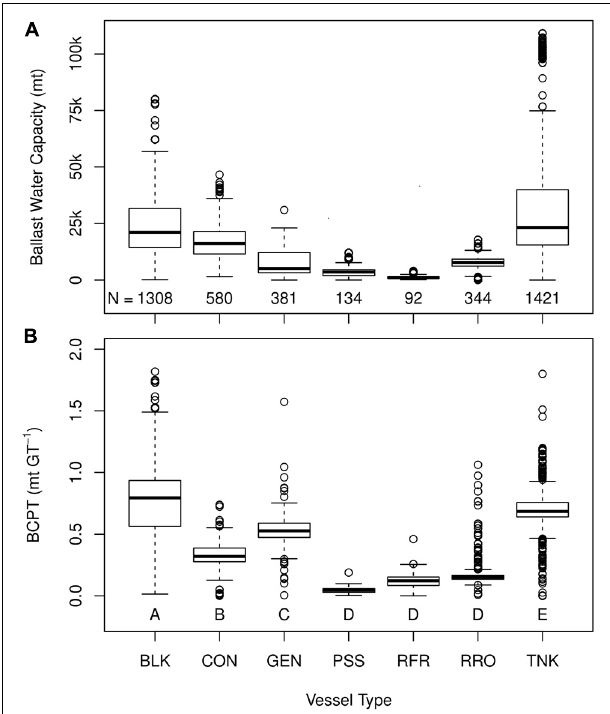
FIGURE 2 | Boxplots showing ballast water capacity (A) and proportion of ballast water capacity to overall vessel size (B) for seven common vessel types. Numbers across the bottom of panel (A) represents the numbers of vessels for each vessel type. Different letters across the bottom of panel (B) indicates which vessel types were significantly different from one another: PSS, RFR, and RRO were not significantly different from each other (Dunn pairwise tests, adjusted p > 0.05), while all other pairs were (Dunn pairwise tests, adjusted p <